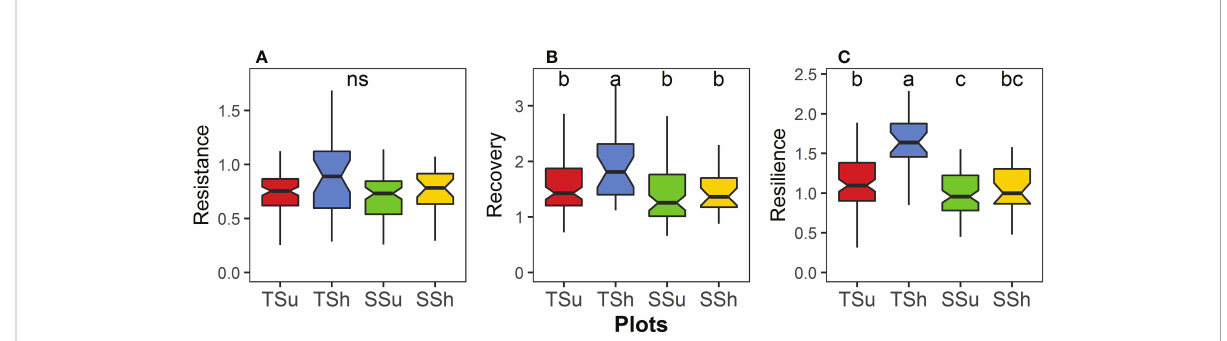
FIGURE 5 Differences in (A) resistance, (B) recovery, and (C) resilience among plots. We compare signi fi cance by pairwise Wilcoxon rank sum test (P < 0.05). “ ns ” means no signi fi cant difference.